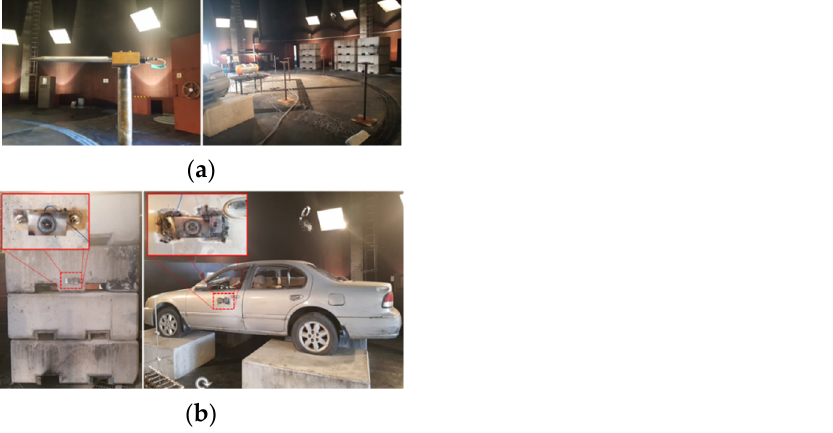
Figure 3. Sensors installed for the experiment: ( a ) incident pressure sensor ; ( b ) reflect pressure sensor .